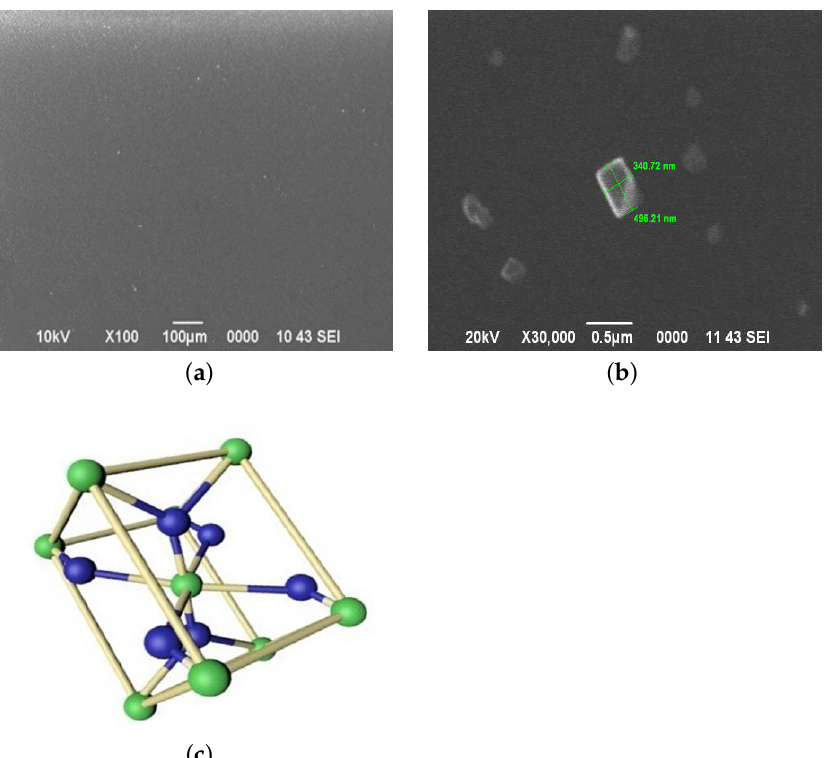
Figure 1. ( a , b ) The surface morphology of the sample surface, on which a film-forming system is applied without the addition of an aqueous ammonia solution. ( c ) Unit cell of SnO 2